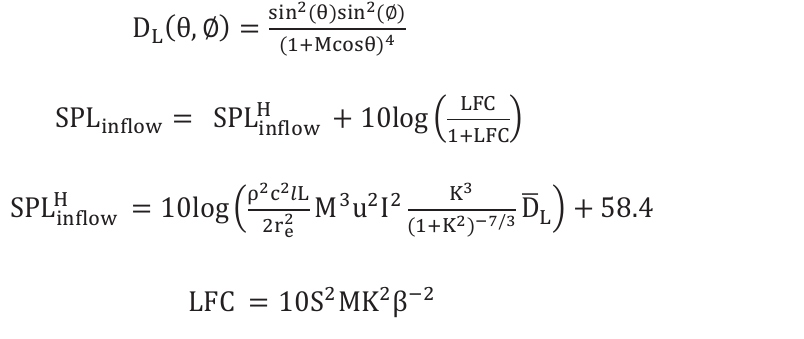
between inertial and viscous forces in flow and is measured along the chord direction of blade, given by Eq. 6. This parameter also varies with pressure side displacement thickness and chord length. For wind turbines the blade experiences moderate to high Reynolds number of order Re = 3.5 × 10 6 to 1.2 × 10 7 flows and vary along the blade span. This source uses high frequency directivity function and is given by Eq.